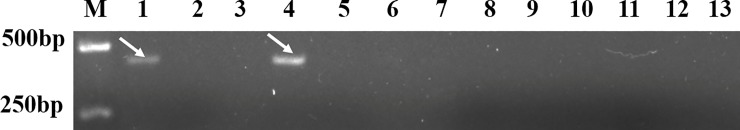
PCR bands generated by DG-3VF and DG-3VR.1, D. villosum; 2–3, CS -D. villosum 1V-2V additional lines; 4, CD-3; 5–8, CS-D. villosum 4V-7V additional lines; 9–13, common wheat cultivars CS, Chuanmai49, Chuanmai50, Chuanmai60, and rye cultivar JZHM. White arrows indicated the 3V chromosome-specific marker DvGS5-1443.